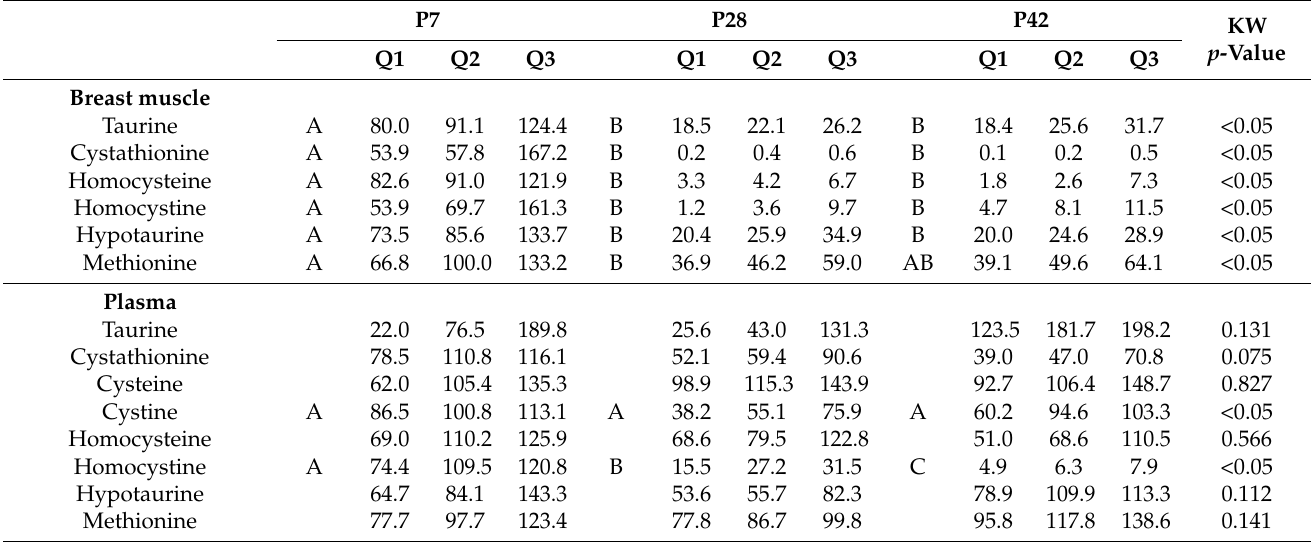
Table 4. Levels of taurine and related metabolites during post-hatch developmental period in